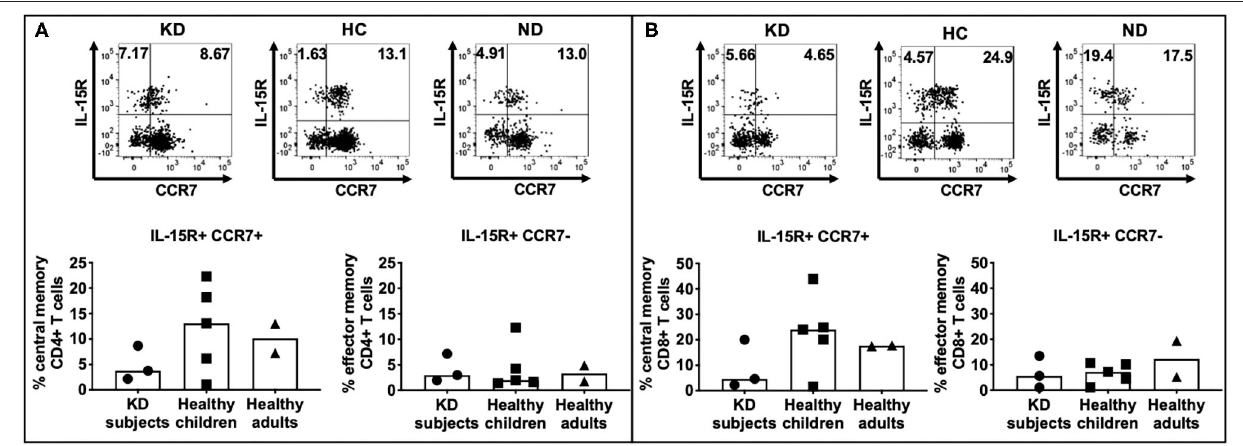
FIGURE 4 | Enumeration of effector and central memory LCWE-specific CD4 + and CD8 + T cells. PBMC from subacute KD subjects ( n = 3; KD 5–7, Table 1 ), healthy children ( n = 5; HC 5–9, Table 1 ), and healthy adults ( n = 2; ND3–4, Table 1 ) were stimulated with LCWE (1 µ g/ml) for 4 days and studied for the expression of IL-15R and CCR7 + on CD4 + HLA-DR + (A) and CD8 + HLA-DR + (B) T cells were studied by flow cytometry to enumerate central memory (IL15R + CCR7 + ) and effector memory (IL-15 + CCR7-) T cells. A representative FACS plot of IL-15R + CCR7 + central memory T cells and IL-15R + CCR7- effector memory T cells from each cohort is shown. In all 3 cohorts, both CD4 + and CD8 + memory T cells were detectable suggesting previous and repeated exposure to the antigen. As expected, effector memory T cells were less numerous than central memory T cells (1.43–22.4% vs. 1.08–12.3% CD4 + T cells and 1.59–43.9% vs. 1.06–19.4% CD8 + T cells, respectively). The data are shown with median and interquartile range. Each symbol is the result derived from each subject tested. The statistical differences between cohorts were tested by one-way ANOVA. A P < 0.05 was considered significant. No difference of CD4 + (central memory, p = 0.4014; effector memory, p = 0.9547) and CD8 + (central memory, p = 0.3662; effector memory, p = 0.5224) central memory and effector memory T cells were found among the 3